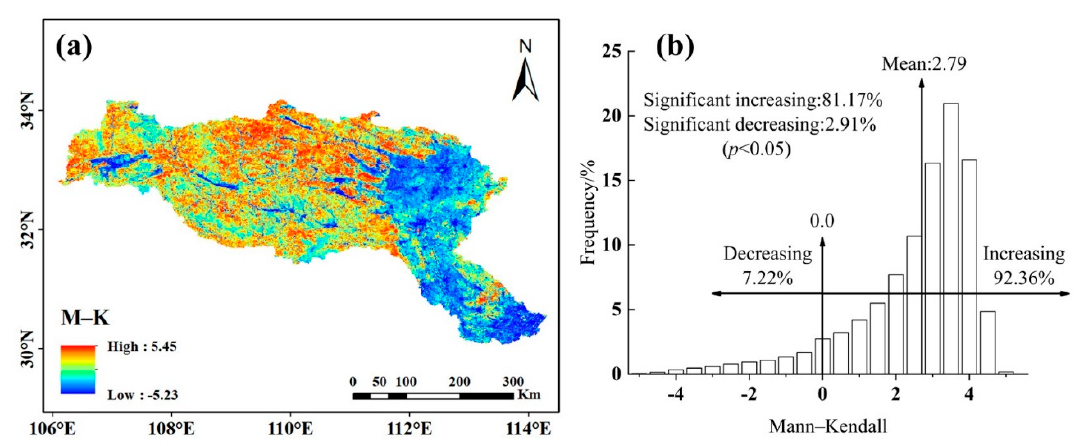
Figure 4. NDVI trends and their distribution in the HJRB: ( a ) M–K values in the HJRB from 2001 to 2008; ( b ) the distribution of M–K values from 2001 to 2018.